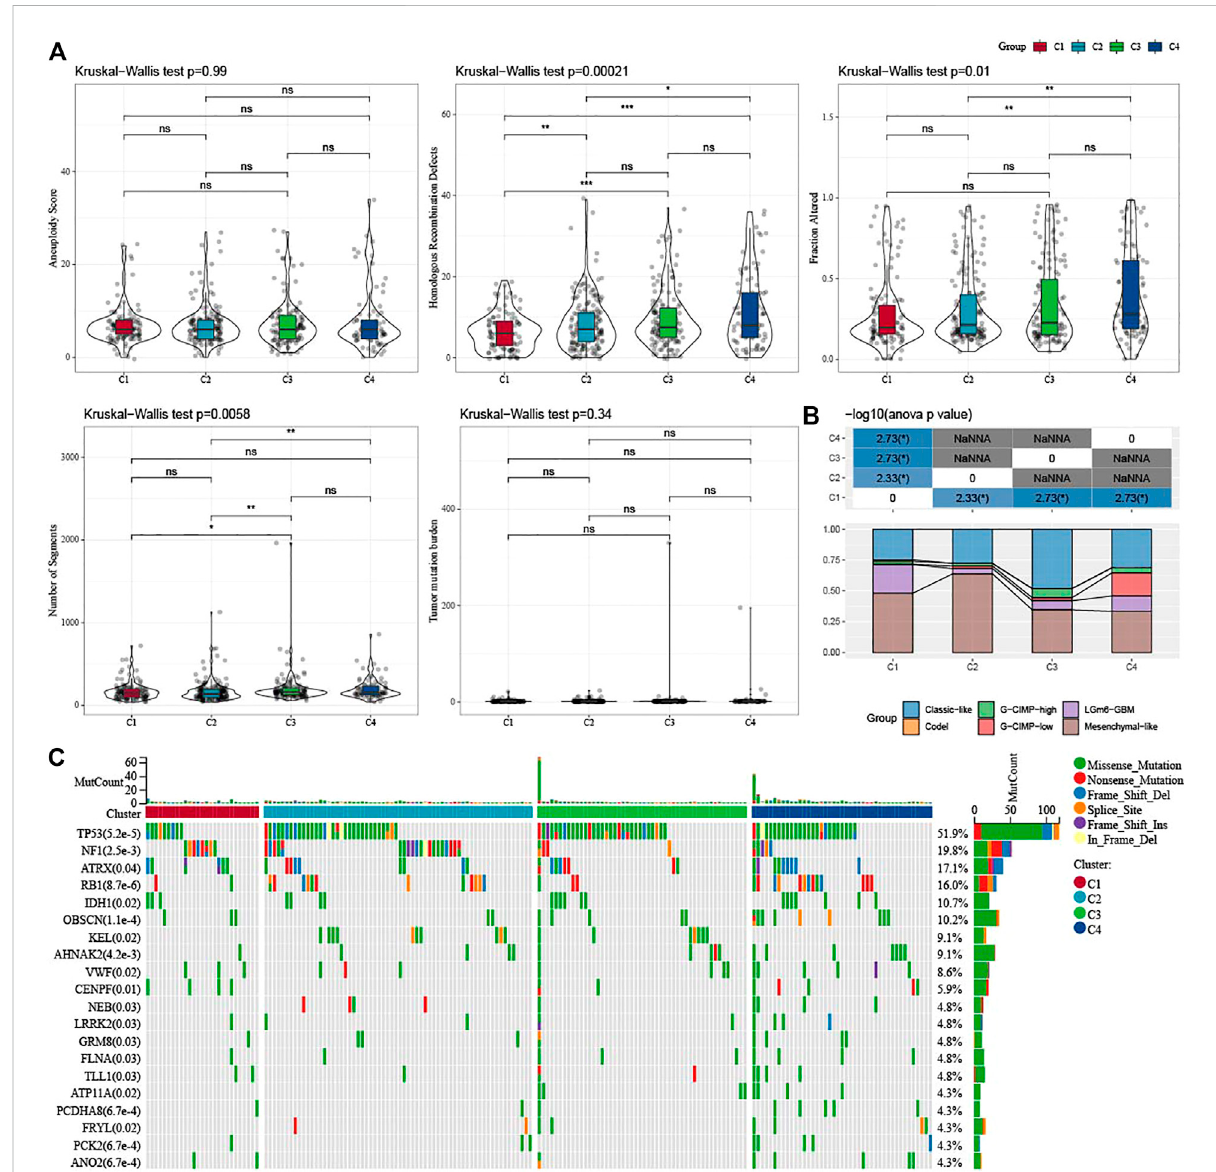
(B) Comparison of four molecular subtypes with other molecular subtypes; (C) Somatic mutations in four molecular subtypes (chi-square test). * p < 0.05; ** p < 0.01; *** p < 0.0001; **** p <